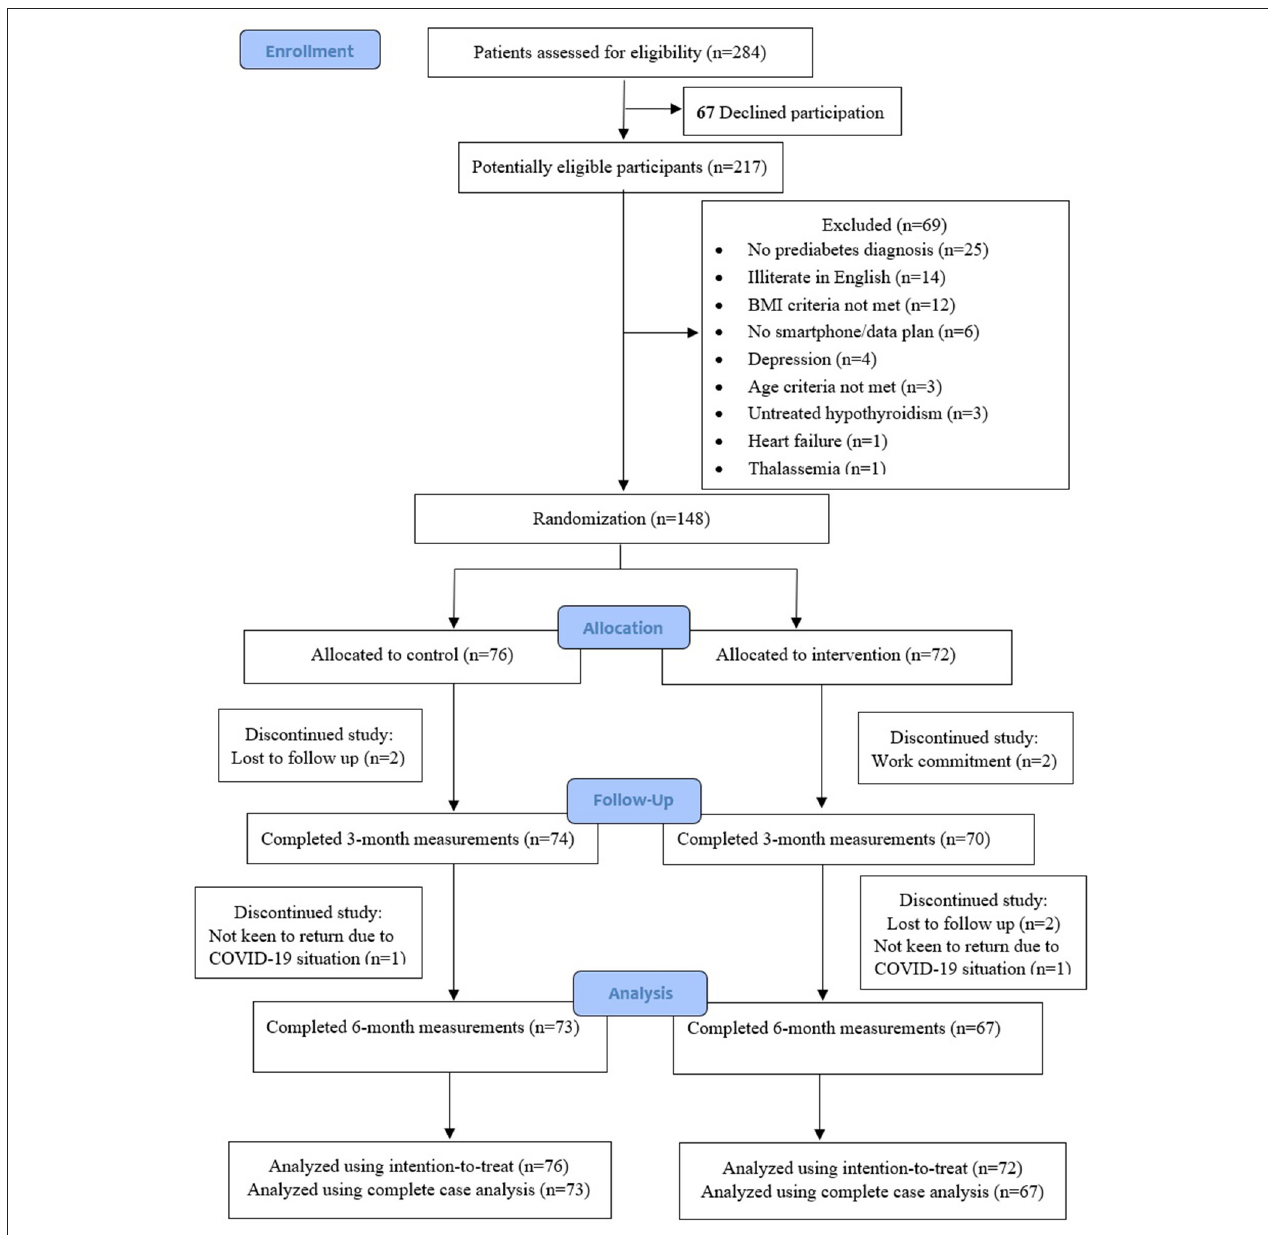
FIGURE 1 | Flowchart of participants screening, recruitment, and